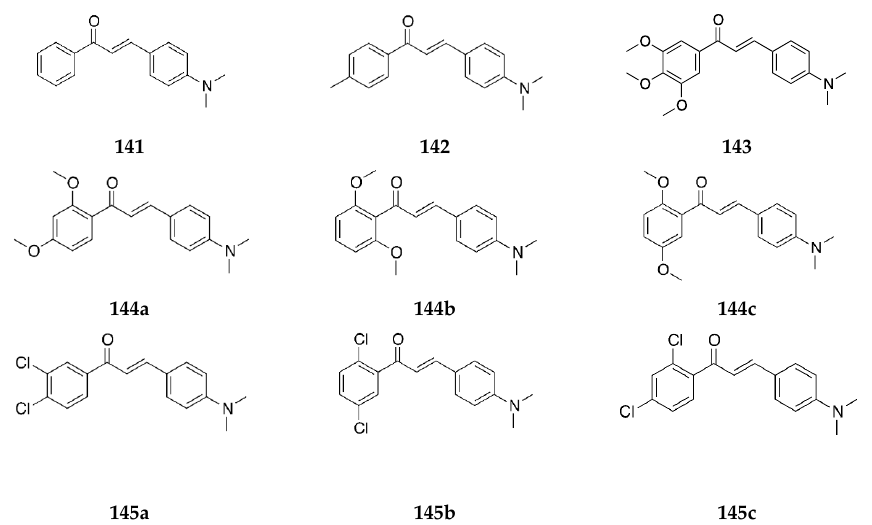
Figure 54. Chemical structure of N,N -dimethyl 4′-aminochalcones derivatives.